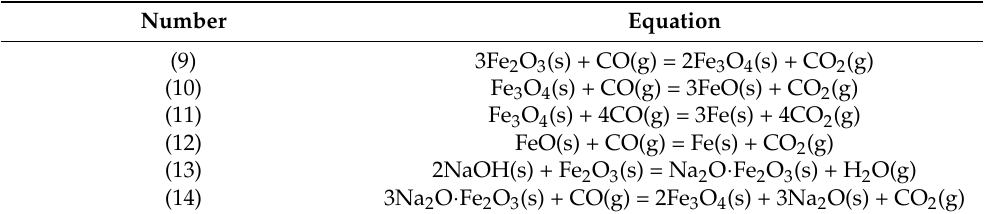
Table 4. Thermodynamic equations of suspension reduction of hematite after addition of